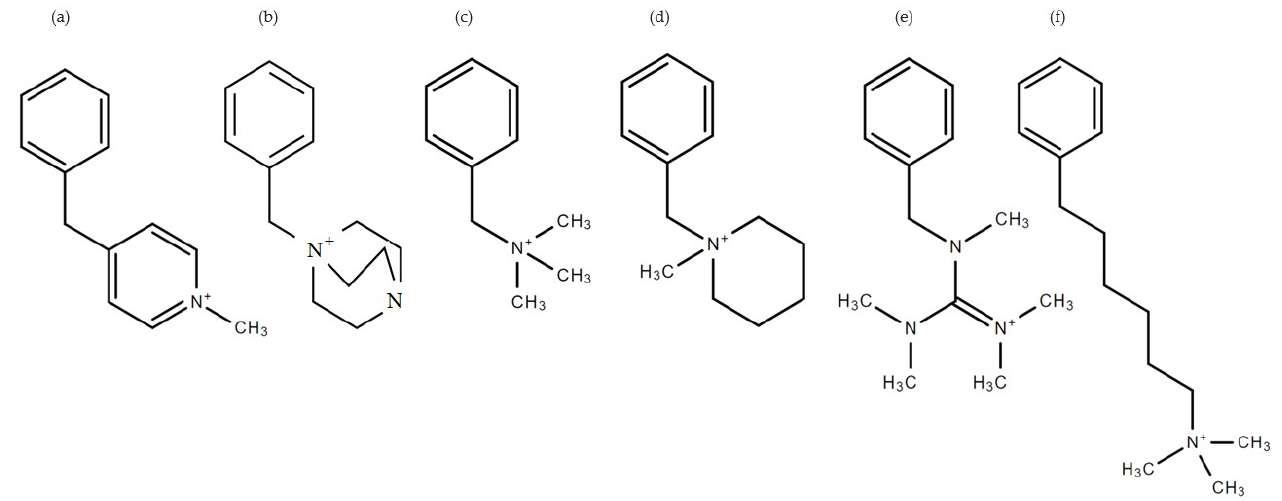
Figure 1. Structure of representative segments containing different QA head groups: The six dif- ferent QA head groups are ( a ) pyridinium, ( b ) 1,4-diazabicyclo [2.2.2] octane (DABCO), ( c ) BTMA, ( d ) n-methyl piperidinium, ( e ) guanidium, and ( f ) TMHA.